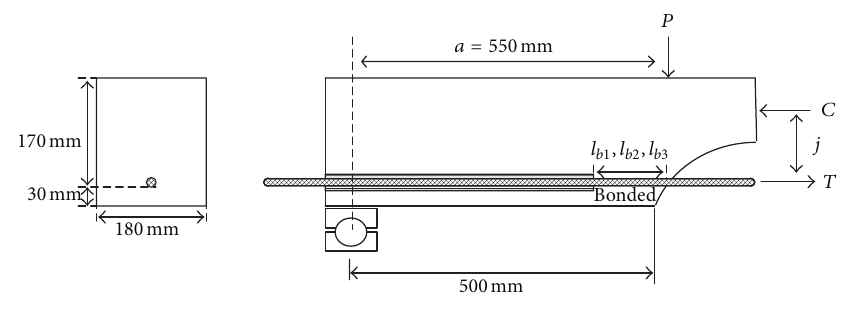
Figure 3: Force equilibrium of cross section at the